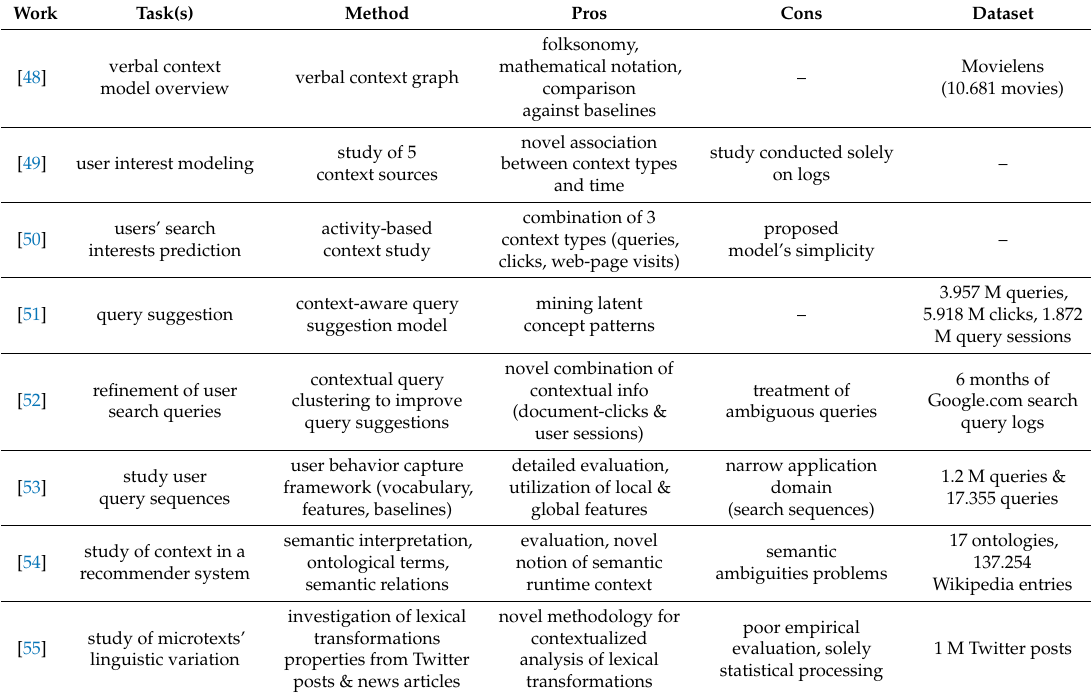
Table 5. Verbal context